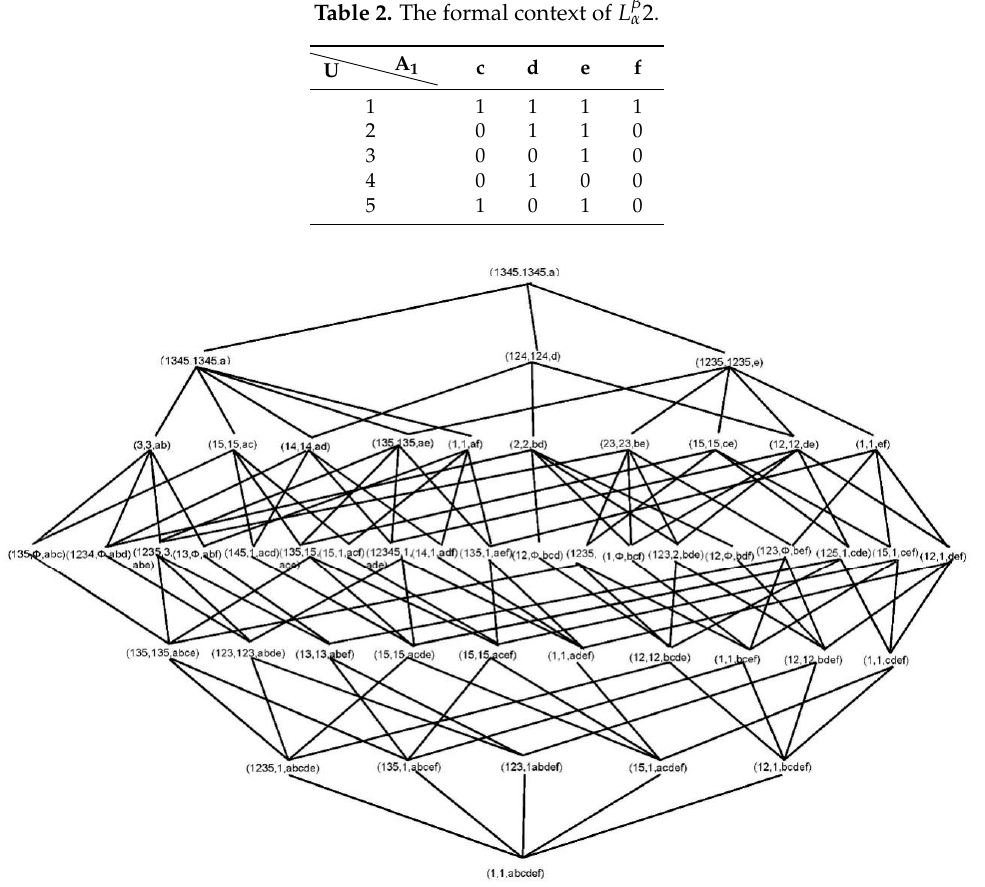
RAUL β RAUL β united by ),,( and ),,( for the Interval α α α 11 22